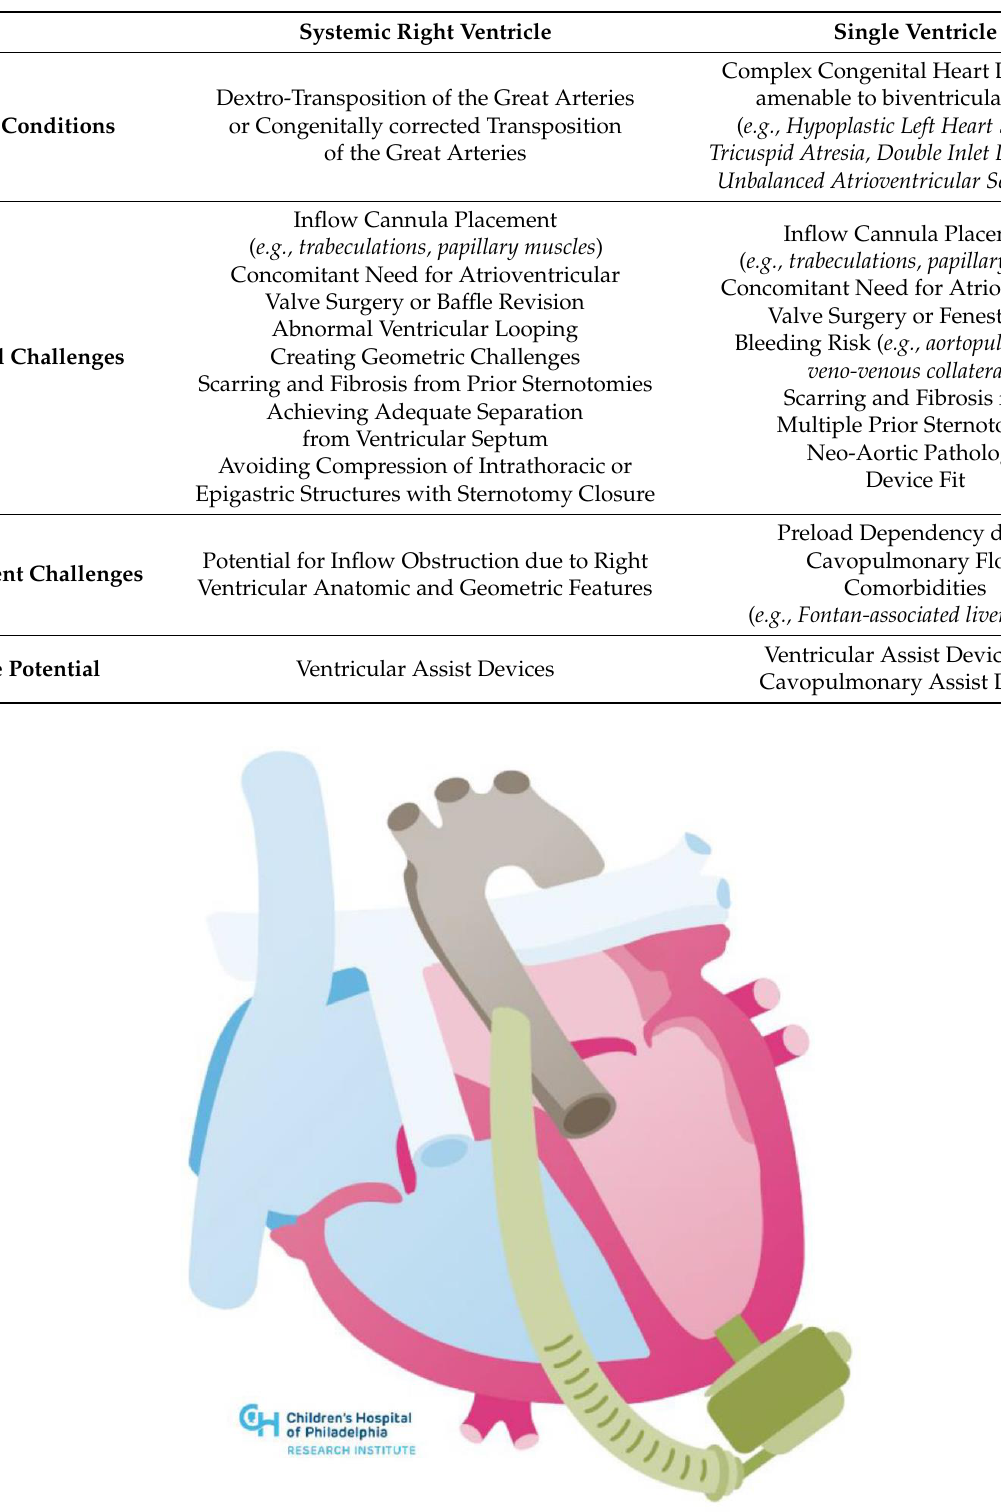
Figure 1. Illustration of HeartMate 3 placement in congenitally corrected transposition of the great